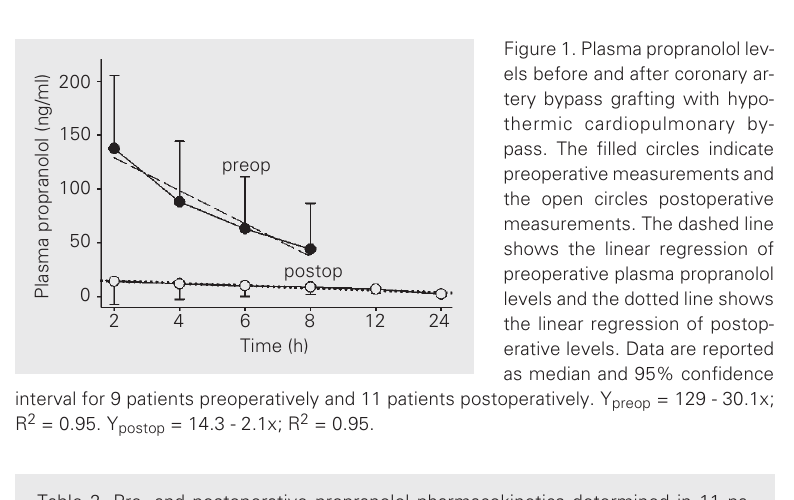
Table 2. Pre- and postoperative propranolol pharmacokinetics determined in 11 pa- tients. Kinetic parameters (reference data)